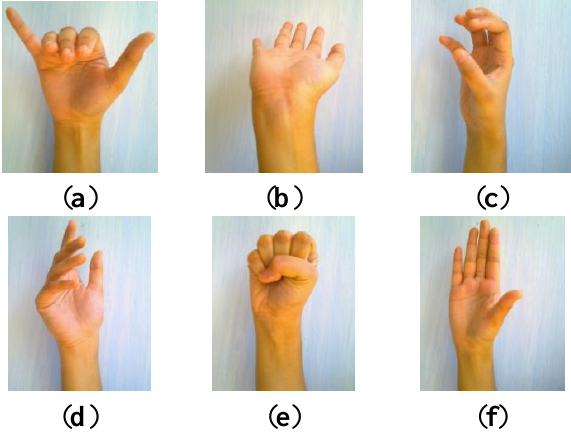
Figure 8. Six motions in the order of ( a ) flexion; ( b ) extension; ( c ) supination; ( d ) pronation; ( e ) hand grasping and ( f ) hand opening [100].